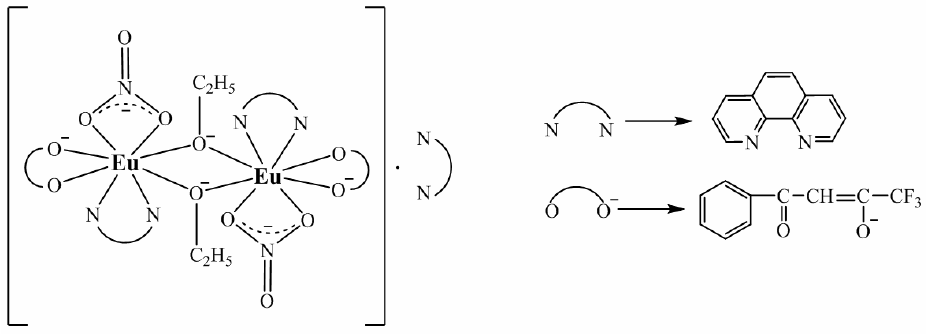
Figure 1. Proposed molecular structure of the complex [Eu(µ 2- OC 2 H 5 )(btfa)(NO 3 )(phen)] 2 phen. High-resolution PL emission spectra (0.2 cm −1 ) were registered with a double grating spectrophotometer DFS-52 (LOMO) (St Petersburg, Russia) and a Hamamatsu photomul- tiplier module H8259-01 (Hamamatsu City, Japan) in a photon counting mode. PL spectra